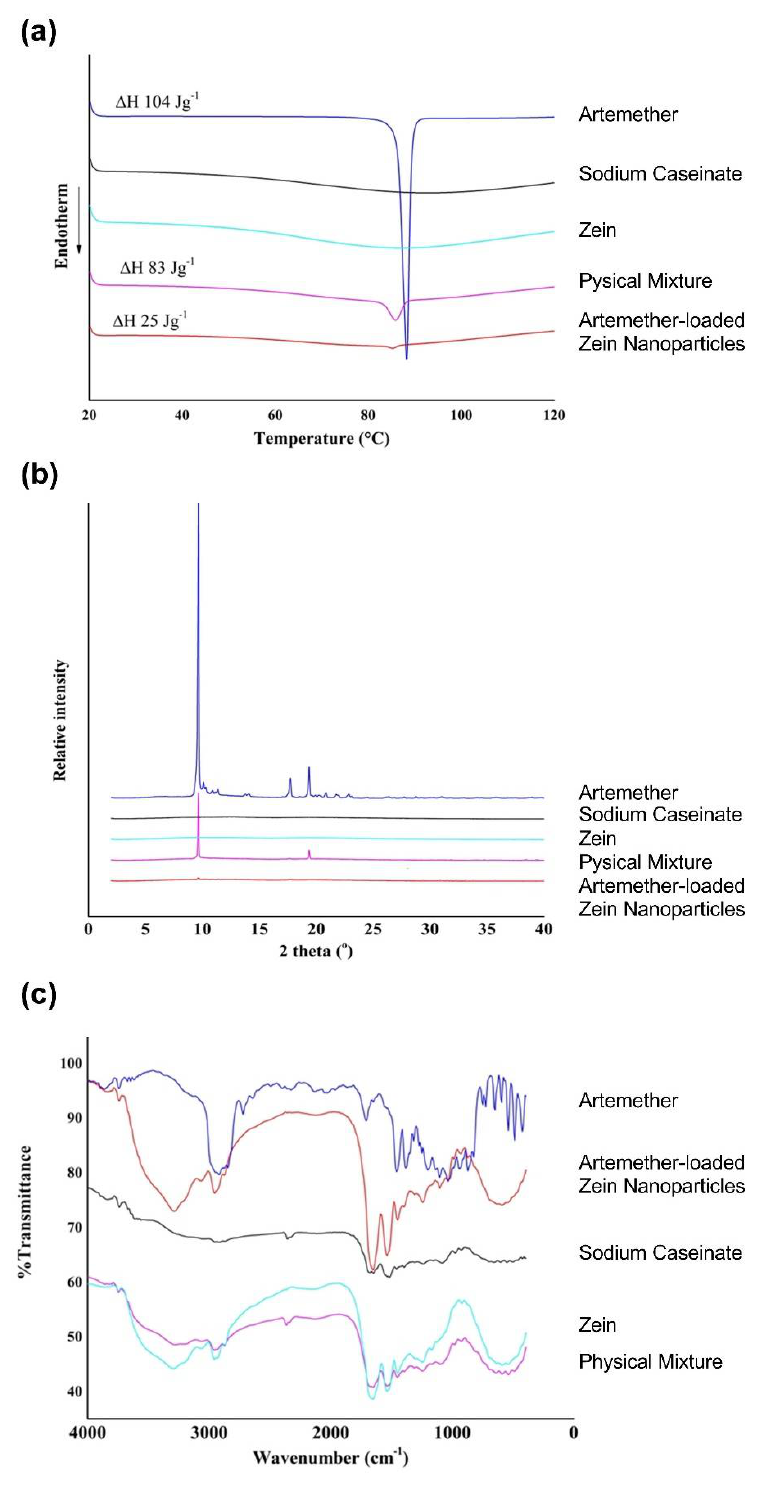
Figure 7. Physical characterization of artemether-loaded zein nanoparticles. Image ( a ) thermograms; ( b ) X-ray powder diffractograms; ( c ) Fourier transform infrared spectra of raw artemether, artemether-loaded zein nanoparticles, sodium caseinate, zein and their physical mixture (mass ratio of 1:5:5).